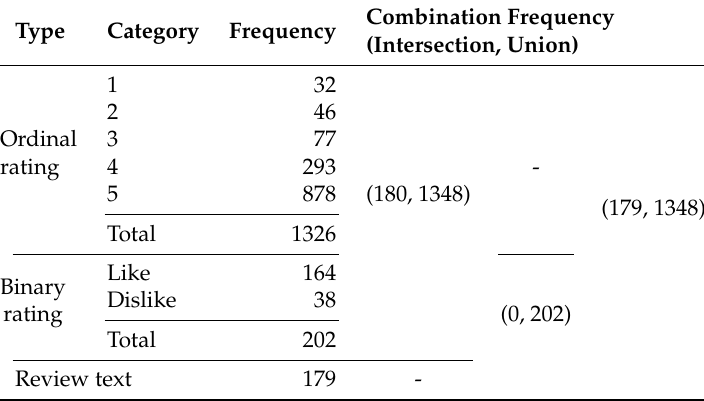
Table 2. Summary of user feedback logs utilized in the